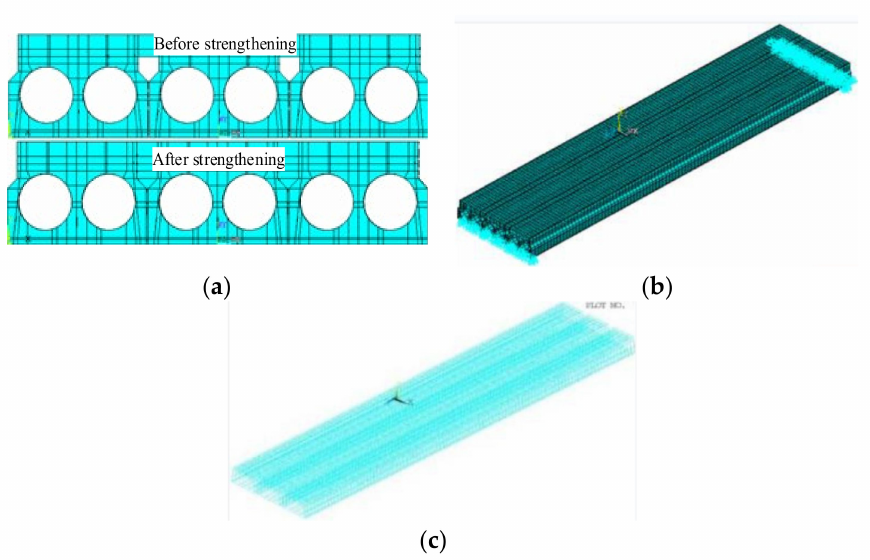
Figure 15. Finite element (FE) model. ( a ) Analysis model. ( b ) Boundary conditions. ( c ) Reinforcement.